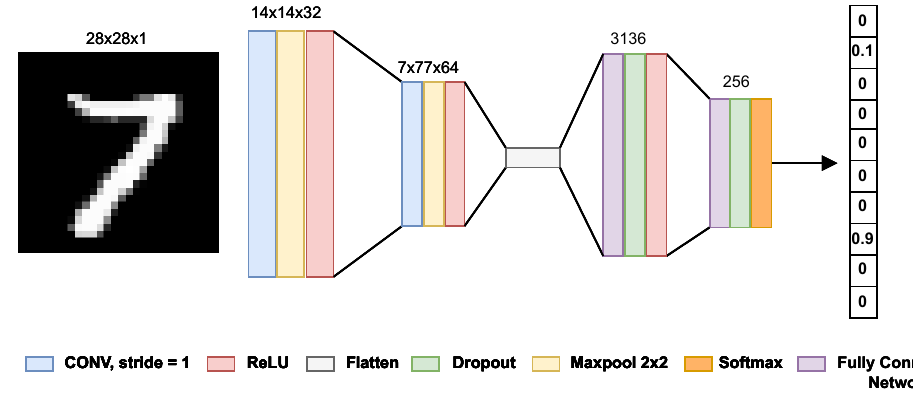
Figure 4. Black-box model f ( · ) used in MNIST. Autoencoder .